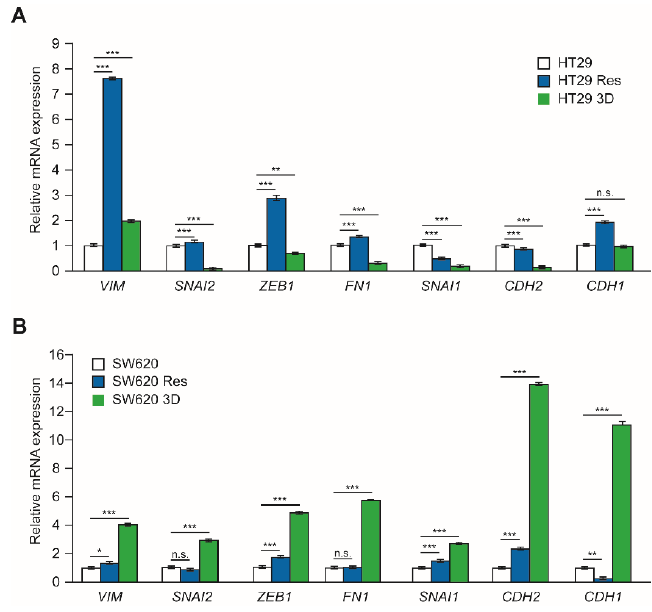
Figure 5. Expression of mRNAs coding for proteins involved in epithelial-mesenchymal transition (EMT). RNA was isolated from CRC cells cultured in adherent plates, non-adherent plates in defined medium (3D), and oxaliplatin-resistant cells cultured under adherent conditions (Res). The relative expression of the mRNAs coding for the protein Vimentin and the transcription factors SNAI1 (SNAIL), SNAI2 (SLUG), Zinc finger E-box-binding homeobox 1 (ZEB1), Fibronectin 1 (FN1), neural cadherin (N-cadherin), and Epithelial cadherin (E-cadherin) was determined by RT-qPCR. Panel ( A ) shows the results obtained for HT29 cells and panel ( B ) shows those obtained for SW620 cells. Experiments were repeated three times with similar results. Statistics: NS, non-significant differences; * p < 0.05; ** p < 0.01; *** p < 0.001.